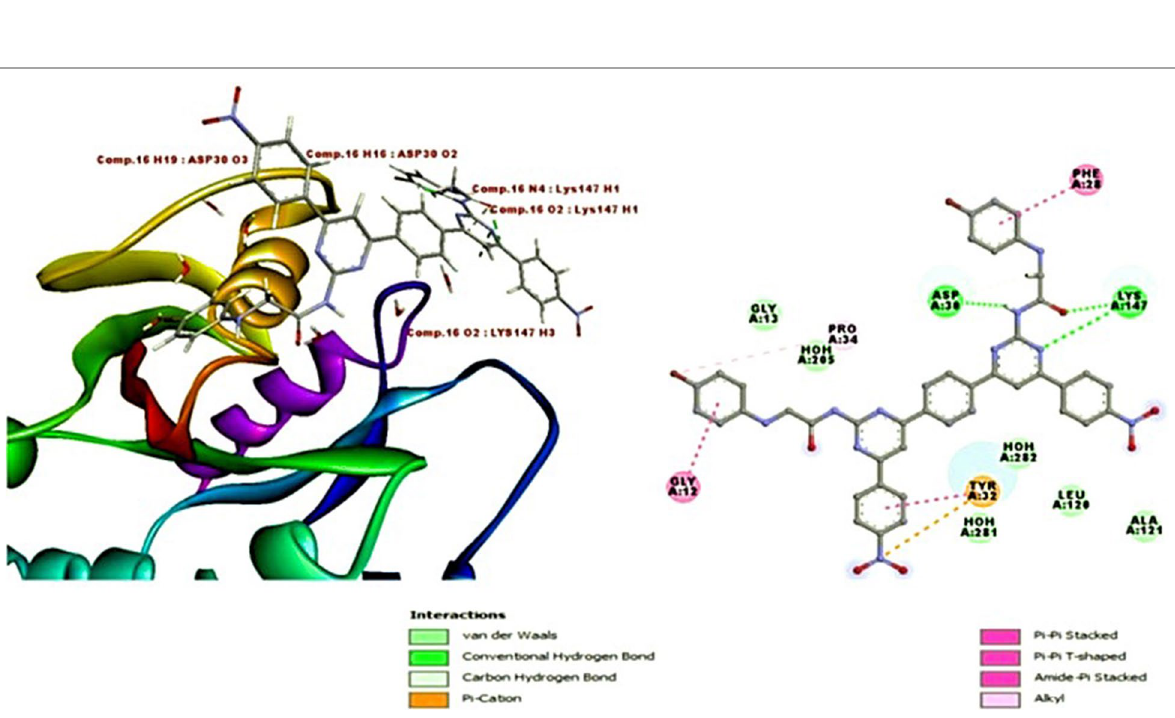
Fig. 3 Details of binding residues and orientation of compound 16 within the GTP binding pocket and secondary structural representation of compound